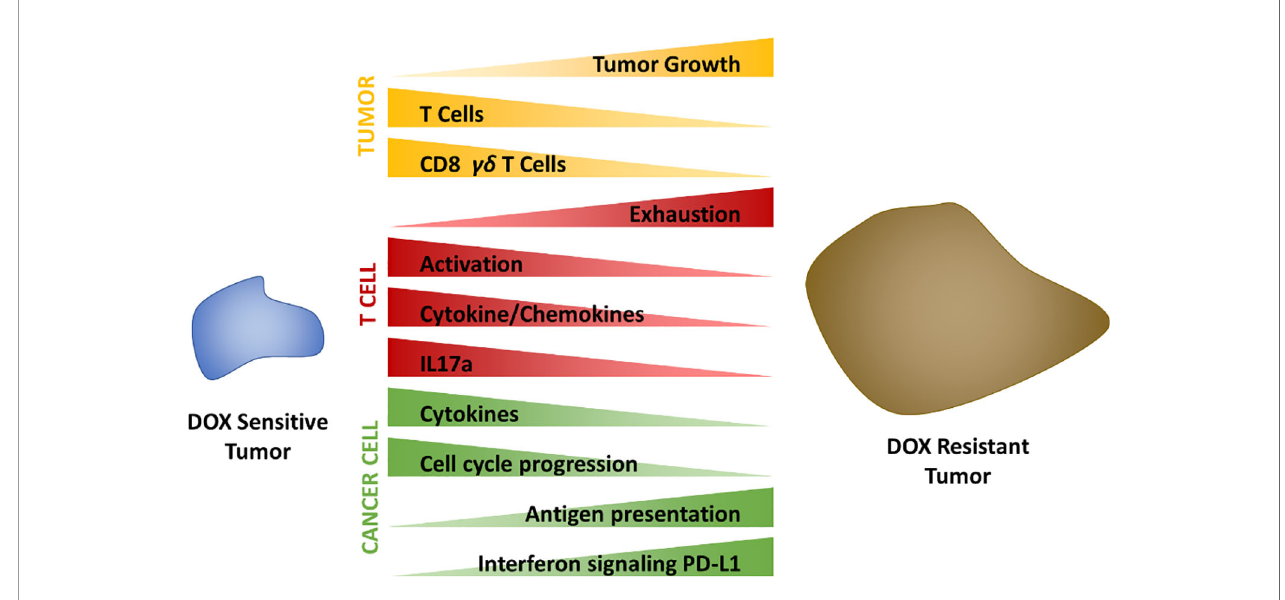
FIGURE 8 | Summary